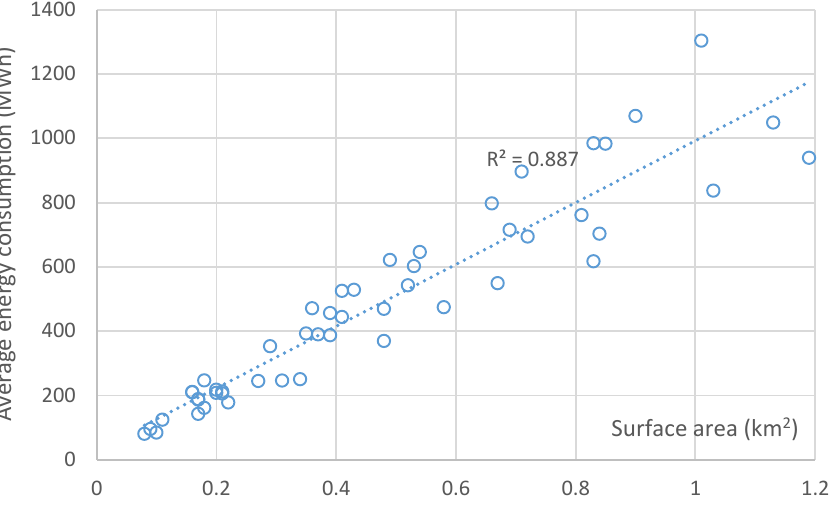
Figure 5. Relationship between the average annual final energy consumption of a municipality and its surface area.